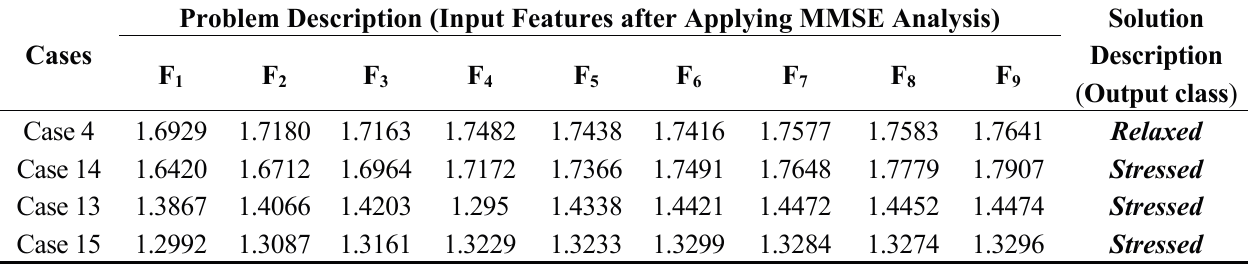
Table 1. An example of a case